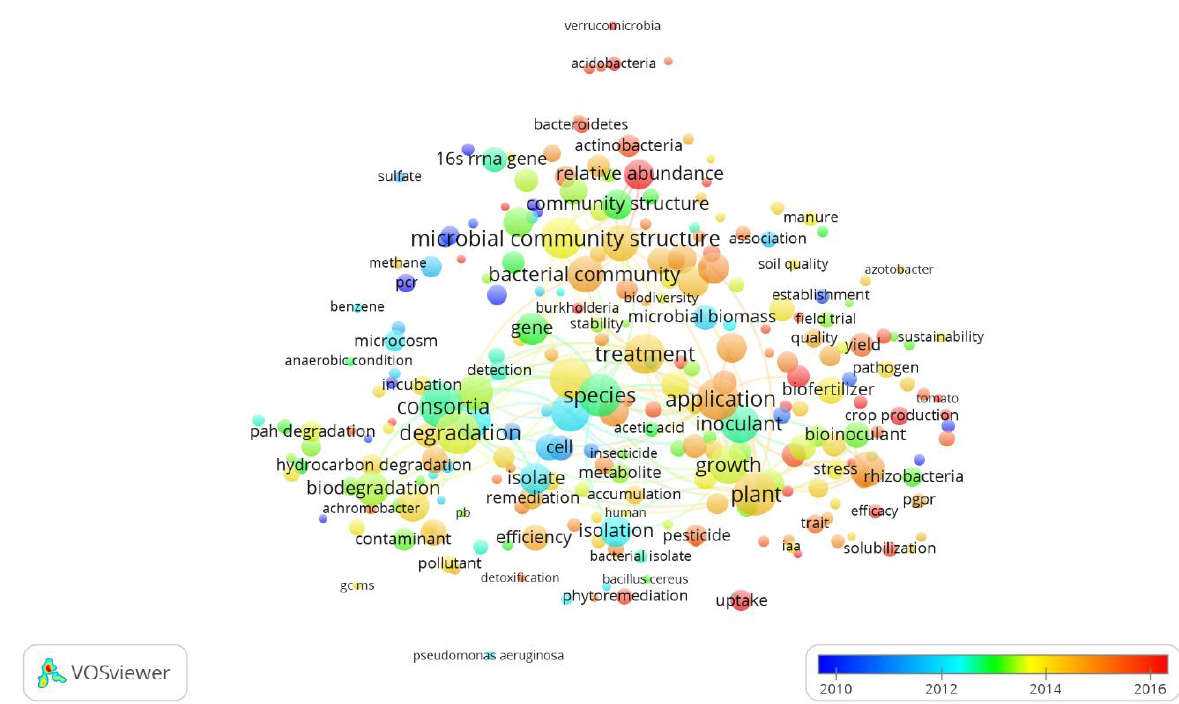
Figure 7. Term map indexed per publication year based on all the Scopus plant phenotyping publications. The time scale is represented by different colors. The size of the term is based on the number of occurrences. The connecting lines indicate the 100 strongest co-occurrence links between terms.